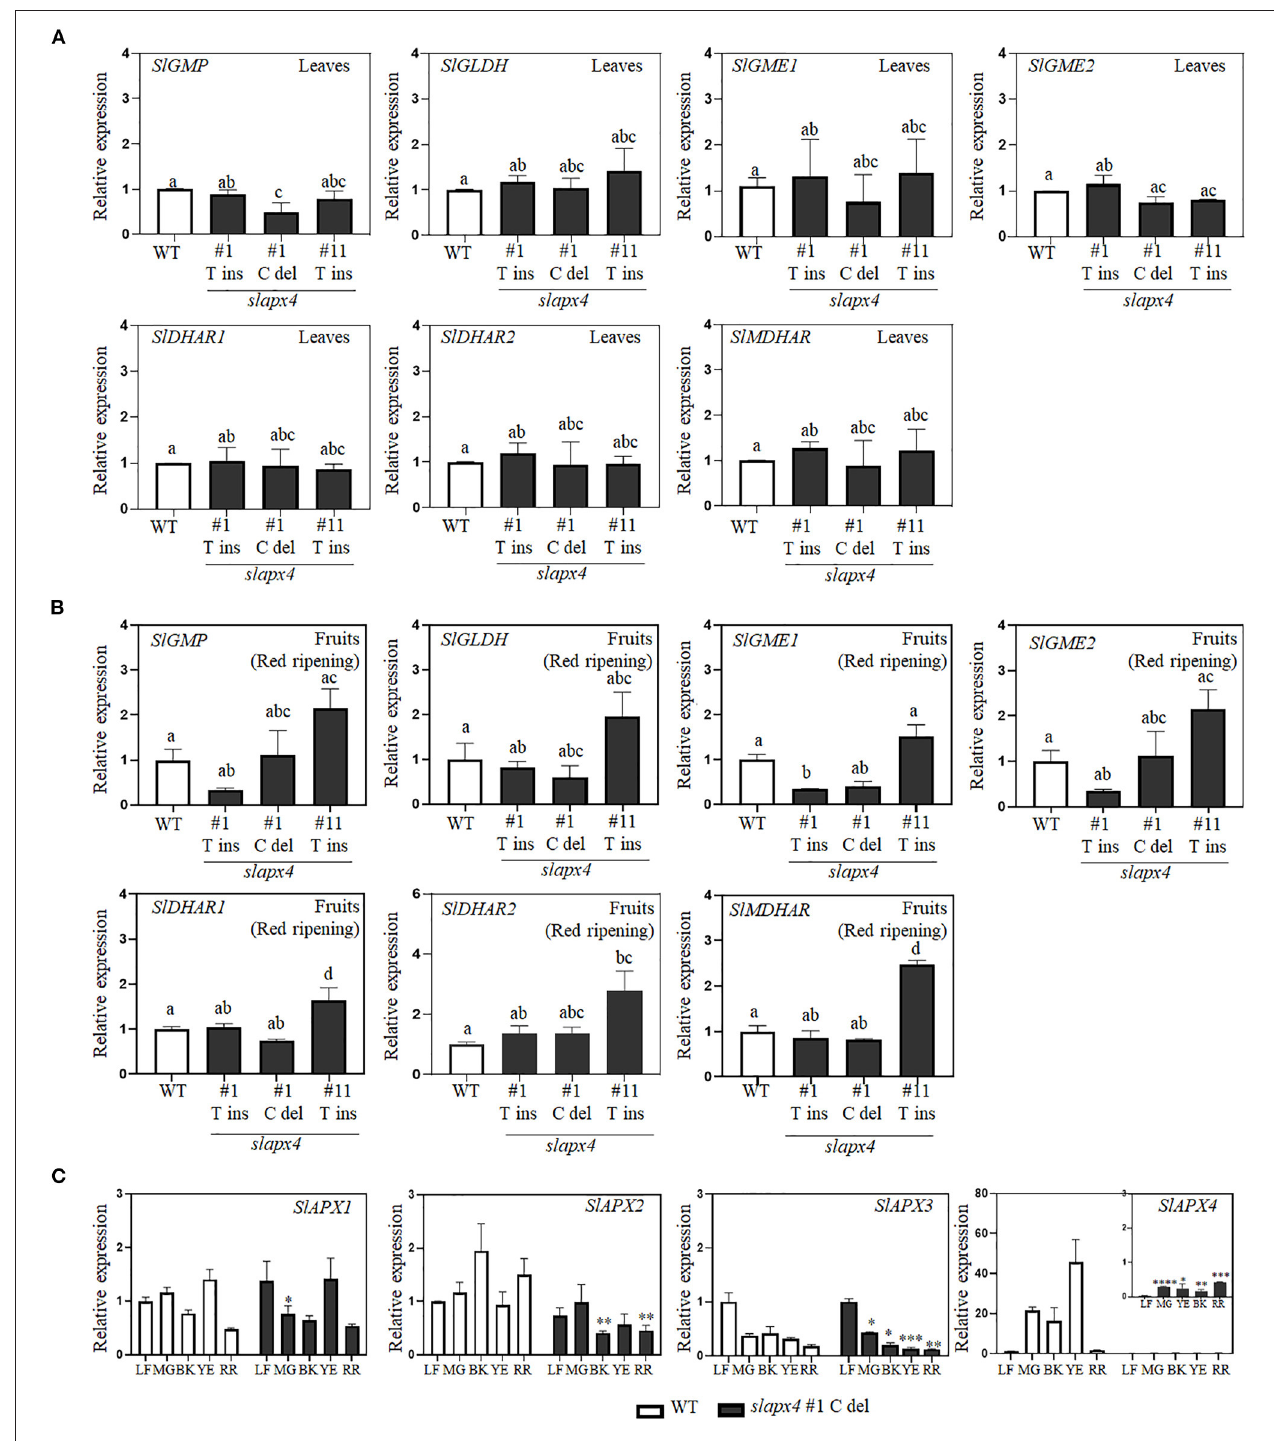
FIGURE 4 | Expression pattern of ascorbate metabolic genes in SLAPX4 mutant plants. (A,B) Relative expression levels of ascorbate metabolic genes in leaves (A) and fruits (B) of wild-type (WT) and SLAPX4 mutant plants ( SLAPX4 #1T ins, #1C del, and #11T ins). (C) The relative expression of SlAPX s in WT and SLAPX4 mutant plants during fruit maturation. Leaves or fruits from three individual tomato plants at the indicated stages of development were pooled for gene expression analysis. SlACT (Soly03g078400) was used as an internal control for normalization. Data represent the mean value + SD of three biological replicates. A significant difference was shown with different letters above the bars for (A) (one-way ANOVA test). Significant difference between WT and SLAPX4 mutant plants was shown by asterisks for (B) (Student’s t -test, * p < 0.05, ** p < 0.001, and *** p < 0.0001). LF, leaves; MG, mature green; BK, breaking; YE, yellowing; RR, red ripening.